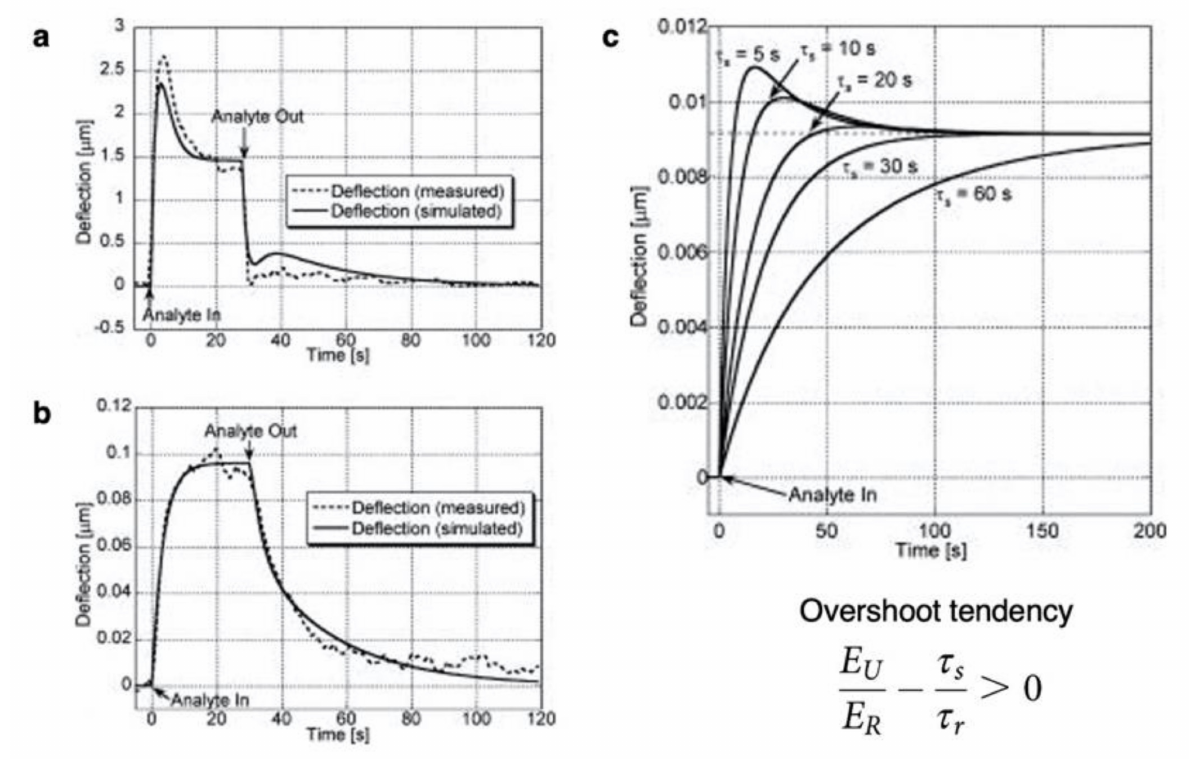
Figure 6. Comparison of experimentally measured signal responses of cantilever-type nanome- chanical sensors and calculated bending responses based on Wenzel’s model. ( a , b ) Compar- ison of experimentally measured signal responses for ( a ) a cyclodextrin-coated cantilever ex- posed to trichloroethylene and ( b ) a poly(diphenoxyphosphazene)-coated cantilever exposed to di-isopropylmethylphsphonate. ( c ) Typical calculated bending response for a cantilever-type nanome- chanical sensor during absorption of analytes for various sorption times but same steady-state sorption-induced elongation. Reprinted with permission from Ref. [95]. Copyright 2008, American Institute of